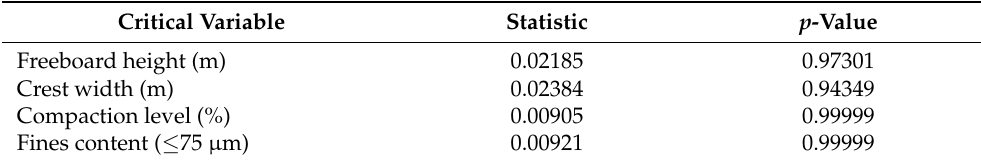
Table 3. Application of KS Test for geometrics and geotechnical control critical variables.